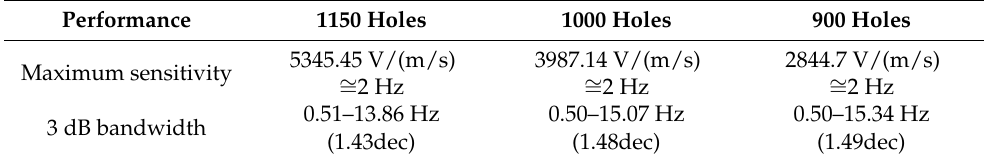
Table 2. Performance comparisons of electrochemical seismometers with 24, 20 and 16 flow